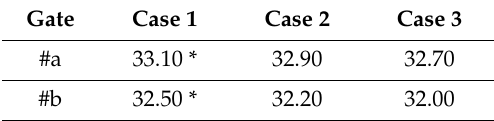
Figure 8. The measured water level at Chenglingji station in 1996. Table 5. The operating water level of the gate in East Dongting Lake (unit: